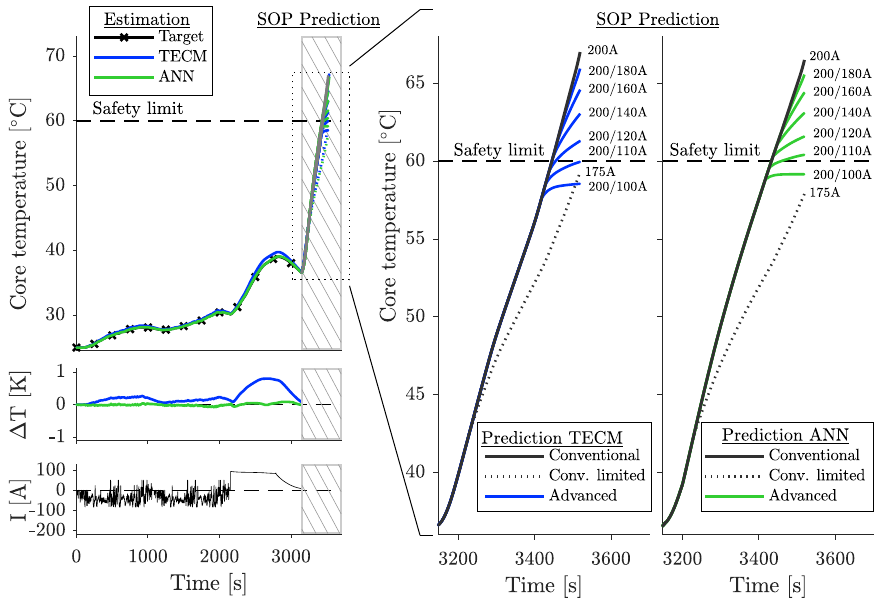
Figure 7. Highway driving and fast charging scenario with in-use SOP prediction in various ways: ANN/TECM approaches are used for the temperature estimation while driving, as well as the prediction of the temperature during SOP